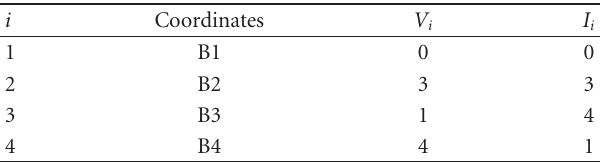
Figure 4: Switch symbol included in the equivalent circuit diagram. Table 1: ( V i , I i ) coordinates for the PWL characteristic of Figure 5(b).